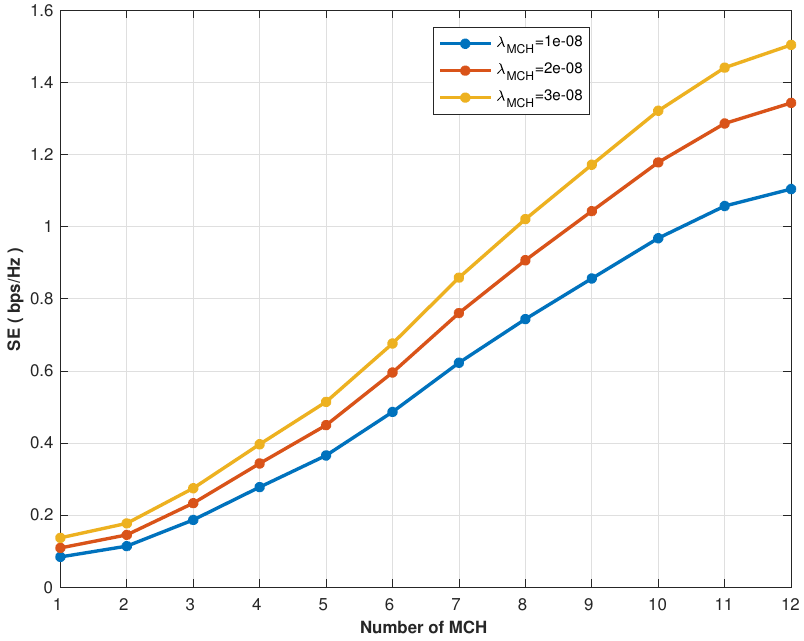
Figure 13. Spectral efficiency vs. MCH number with different